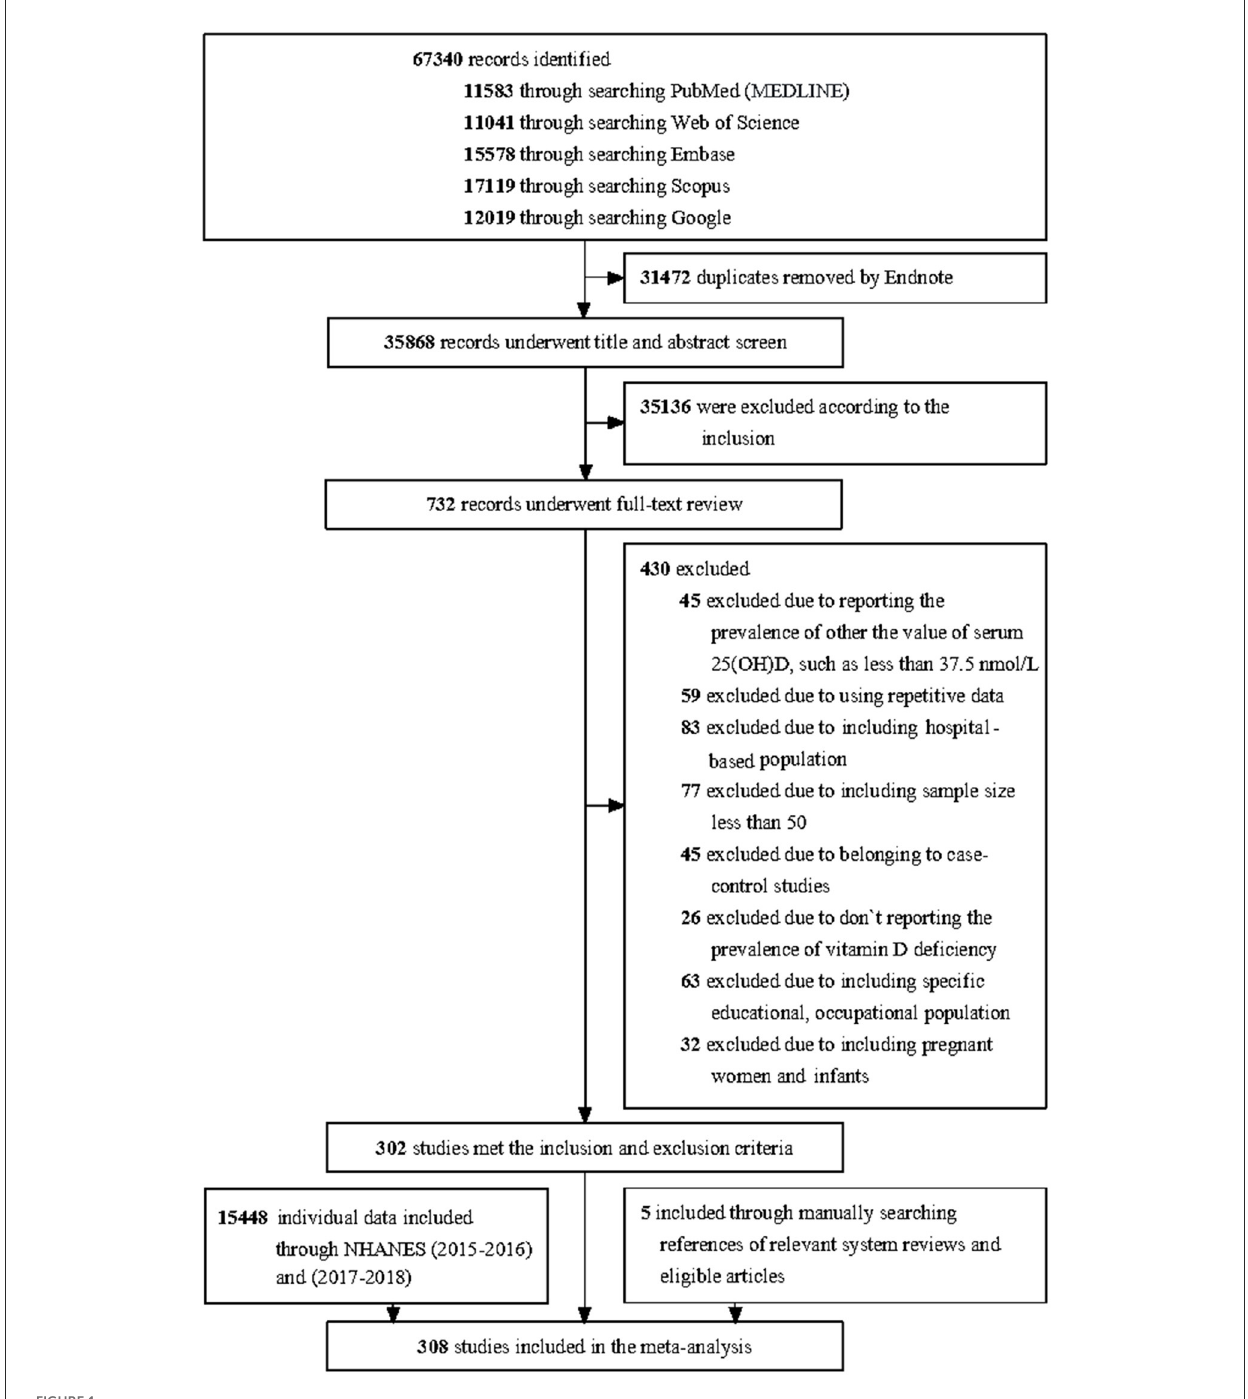
FIGURE1 PRISMA flow